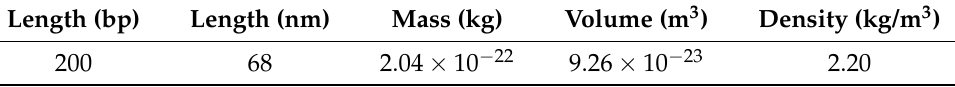
Table 2. Characterization of the biomarker